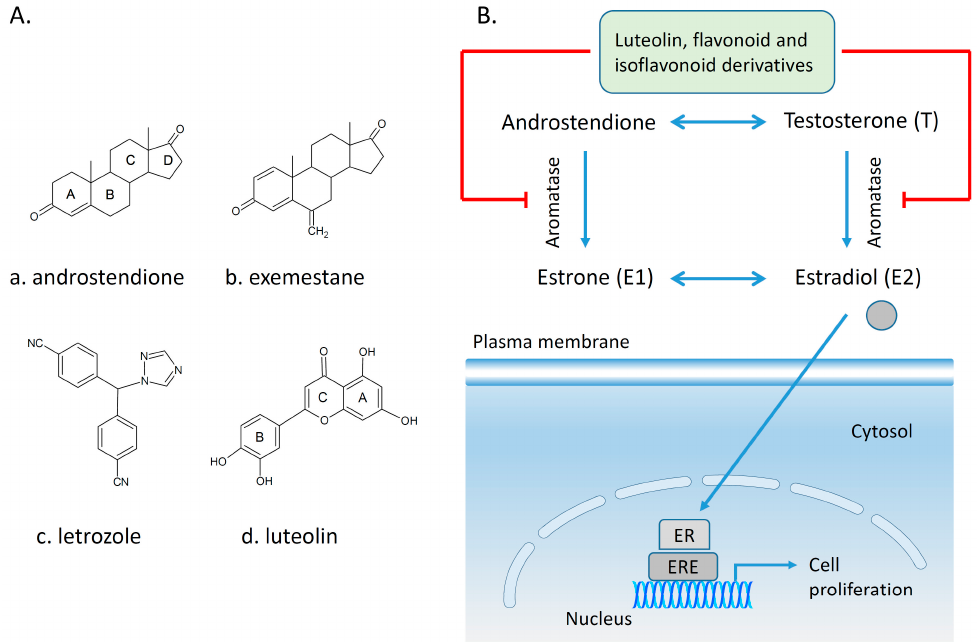
Figure 1. Poyphenols as aromatase inhibitory molecules. ( A ) Chemical structure of aromatase